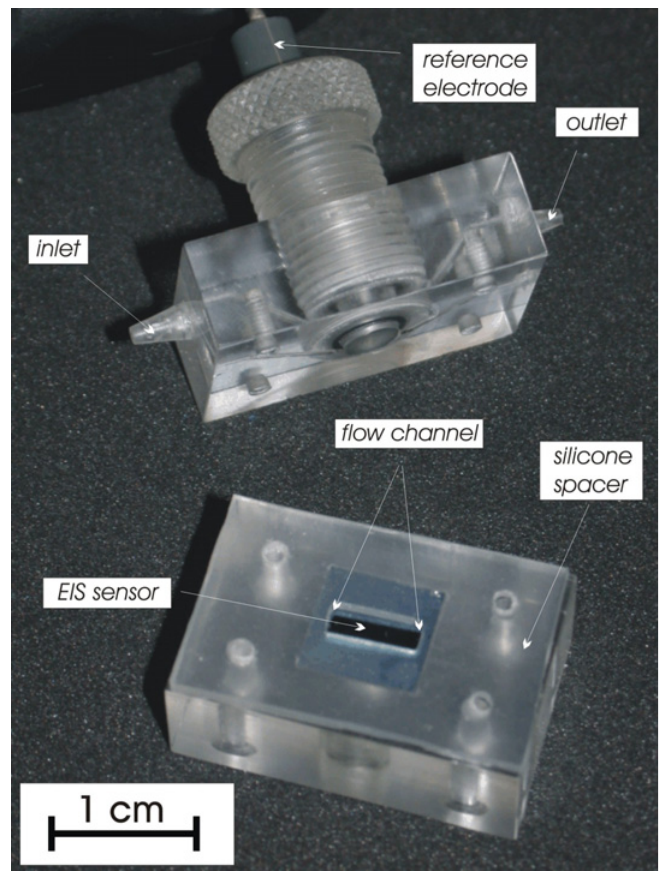
Figure 2. Photo of the developed flow-through